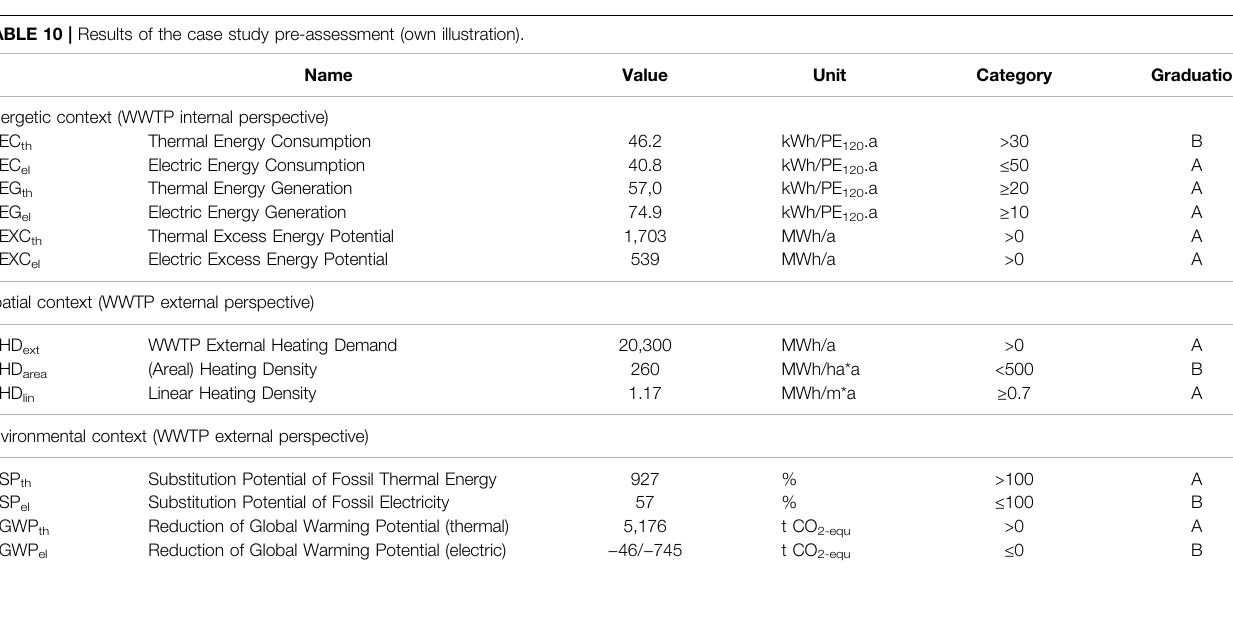
TABLE 10 | Results of the case study pre-assessment (own